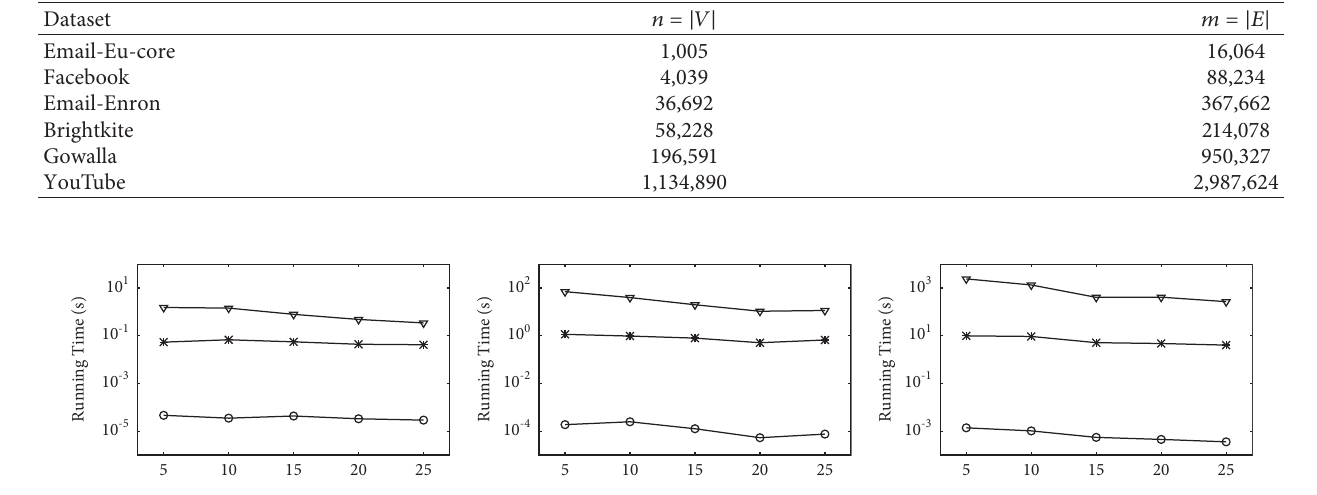
Table 2: Statistics of datasets.